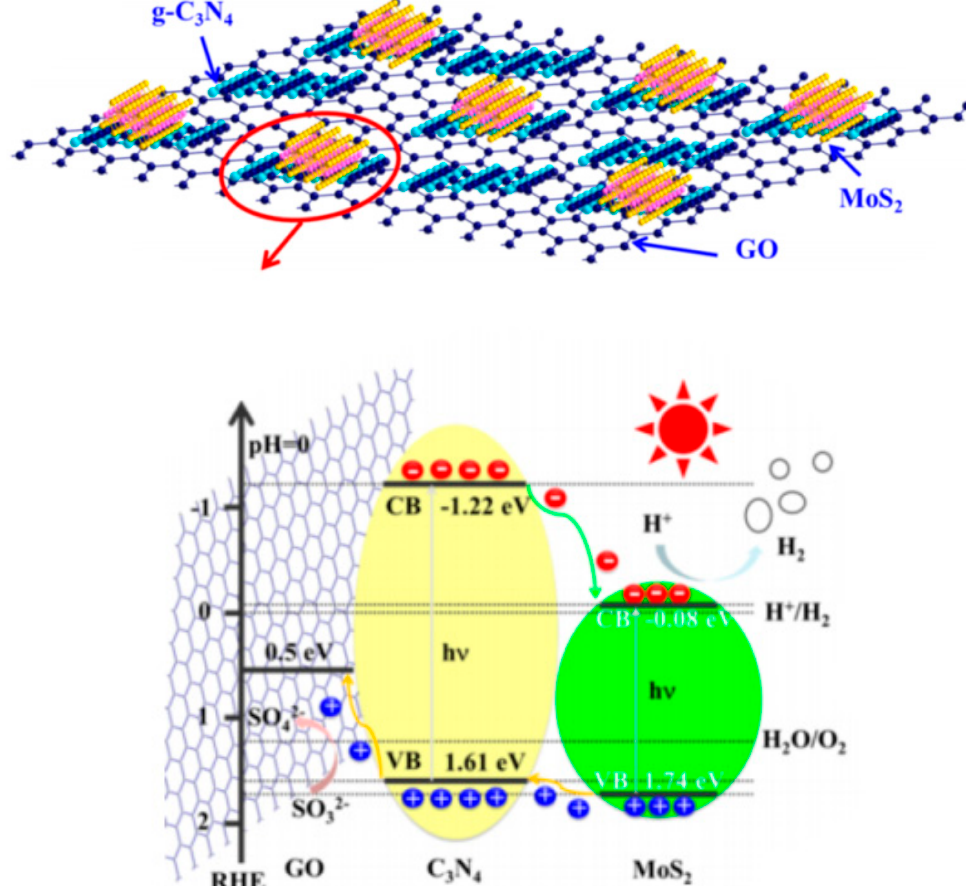
Figure 5. Schematics of MoS2/g-C3N4/GO composite and charge carrier separation. (Reprinted with permission from [104]. Copyright (2017), American Chemical Society.)